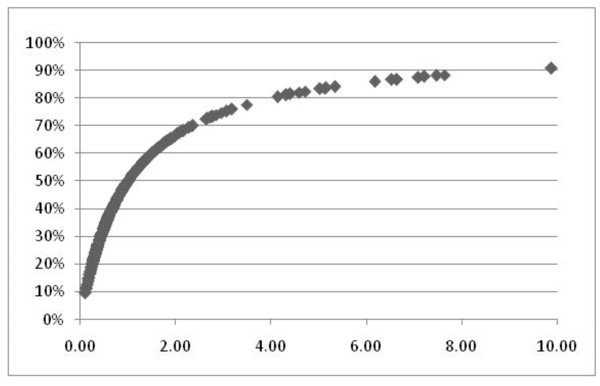
Probability curve for patients with hospital care costs exceeding $3,000 monthly. Probability of Hospital Care exceeding $3,000 in any single month versus the linear predictor (lp) of the logit calculation for average serum levels of PTH, phosphate and albumin.